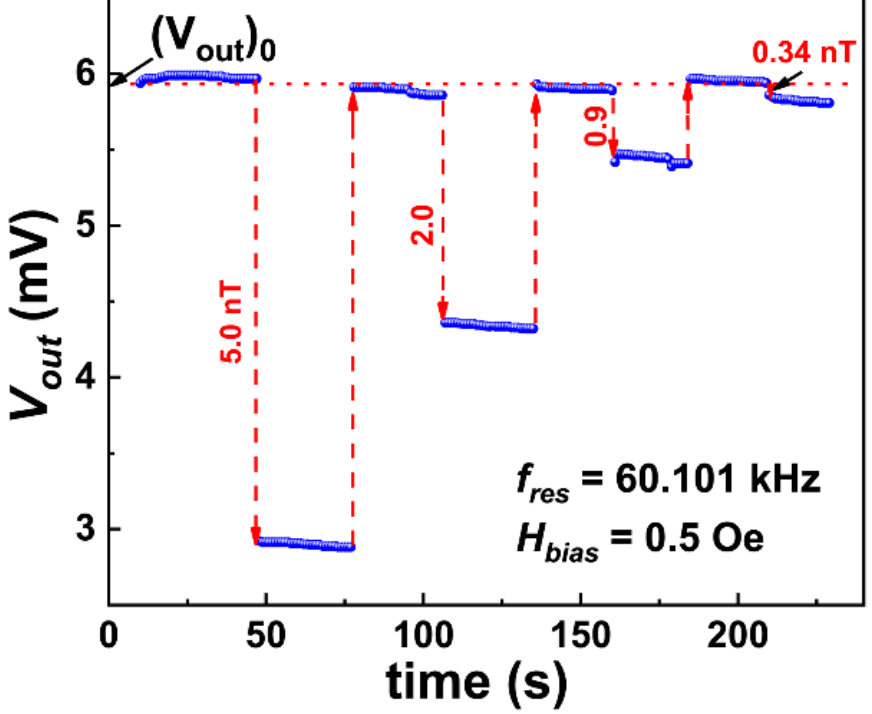
Figure 5. DC magnetic field resolution 𝐻 𝑟𝑠𝑙𝐷𝐶 at 𝑓 𝑟𝑒𝑠 = 60.101 kHz and 𝐻 𝑏𝑖𝑎𝑠𝐷𝐶 = 0.5 Oe.